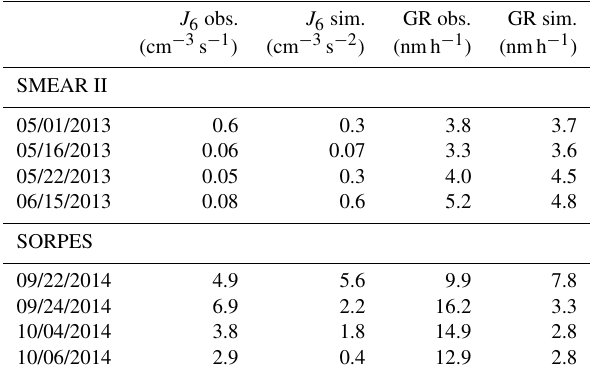
Table 3. The observed and simulated formation rates of 6nm par- ticles ( J 6 ) and growth rates of 6–30nm particles (GR) on chosen NPF days (MM/DD/YYYY) at each site. J 6 obs. J 6 sim. GR obs. GR